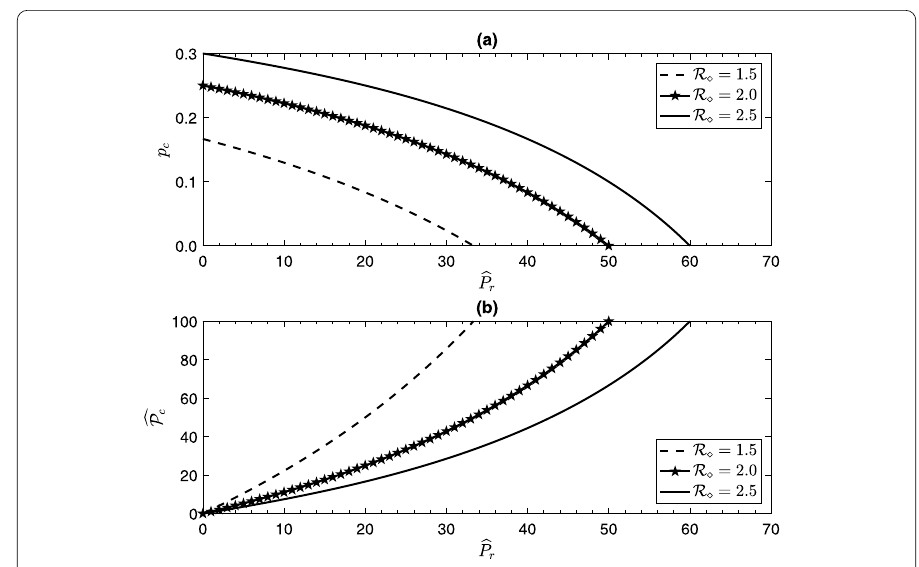
Figure 3 The critical vaccination coverage level p c required to eliminate the infection as a function of the percent reduction in the contact time activity of infected individuals (cid:2) P r is shown in part ( a ), while the percent reduction in the critical vaccination coverage level (cid:12) P c required to eliminate the infection as a function of the percent reduction in the contact time activity of infected individuals (cid:2) P r is shown in part ( b ), for different values of the basic reproduction number R